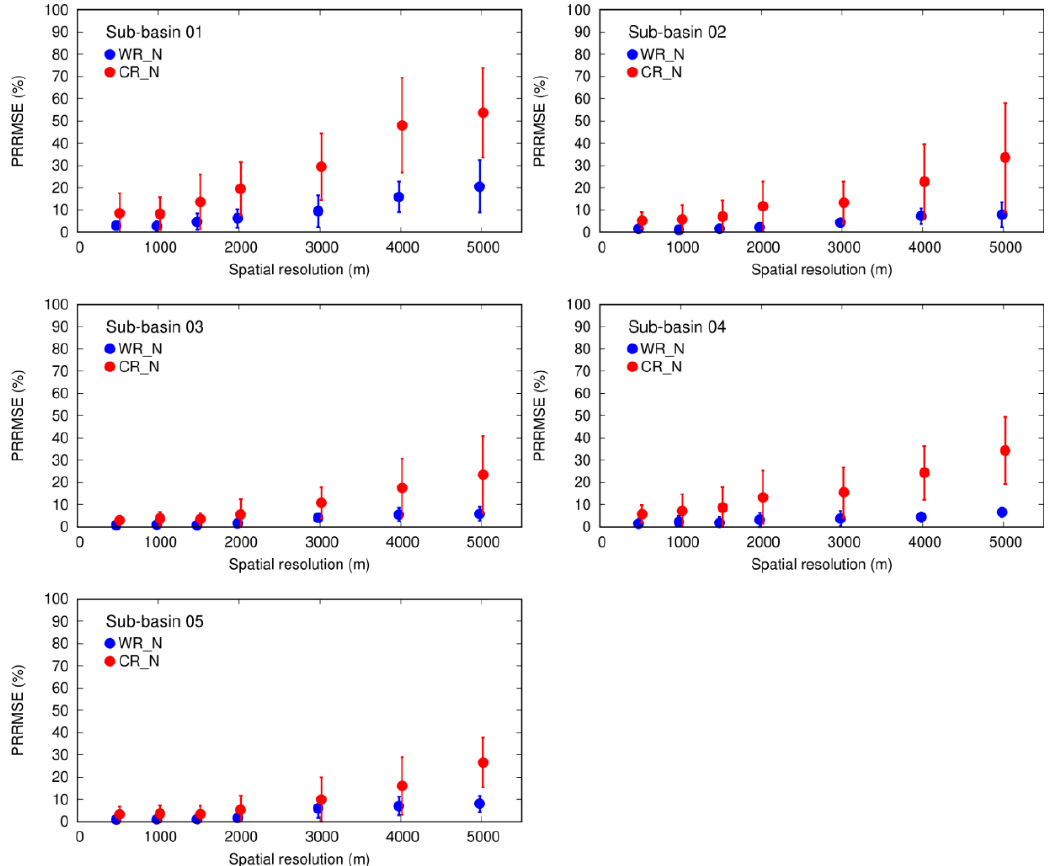
Figure 13. Percent relative root mean square error profile with the standard deviation (vertical error bar) of the simulated discharge at each sub-basin using different rainfall data spatial resolutions (WR_N: widespread rain (WR) cases; CR_N: convective rain (CR) cases).